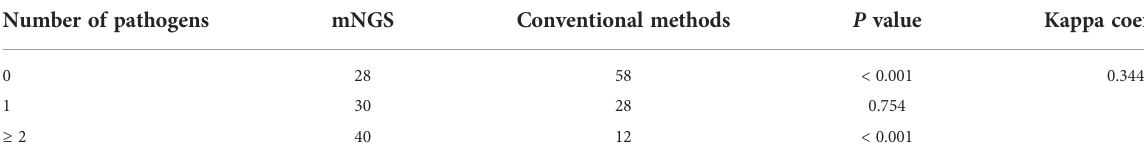
mNGS, metagenomic next-generation sequencing.